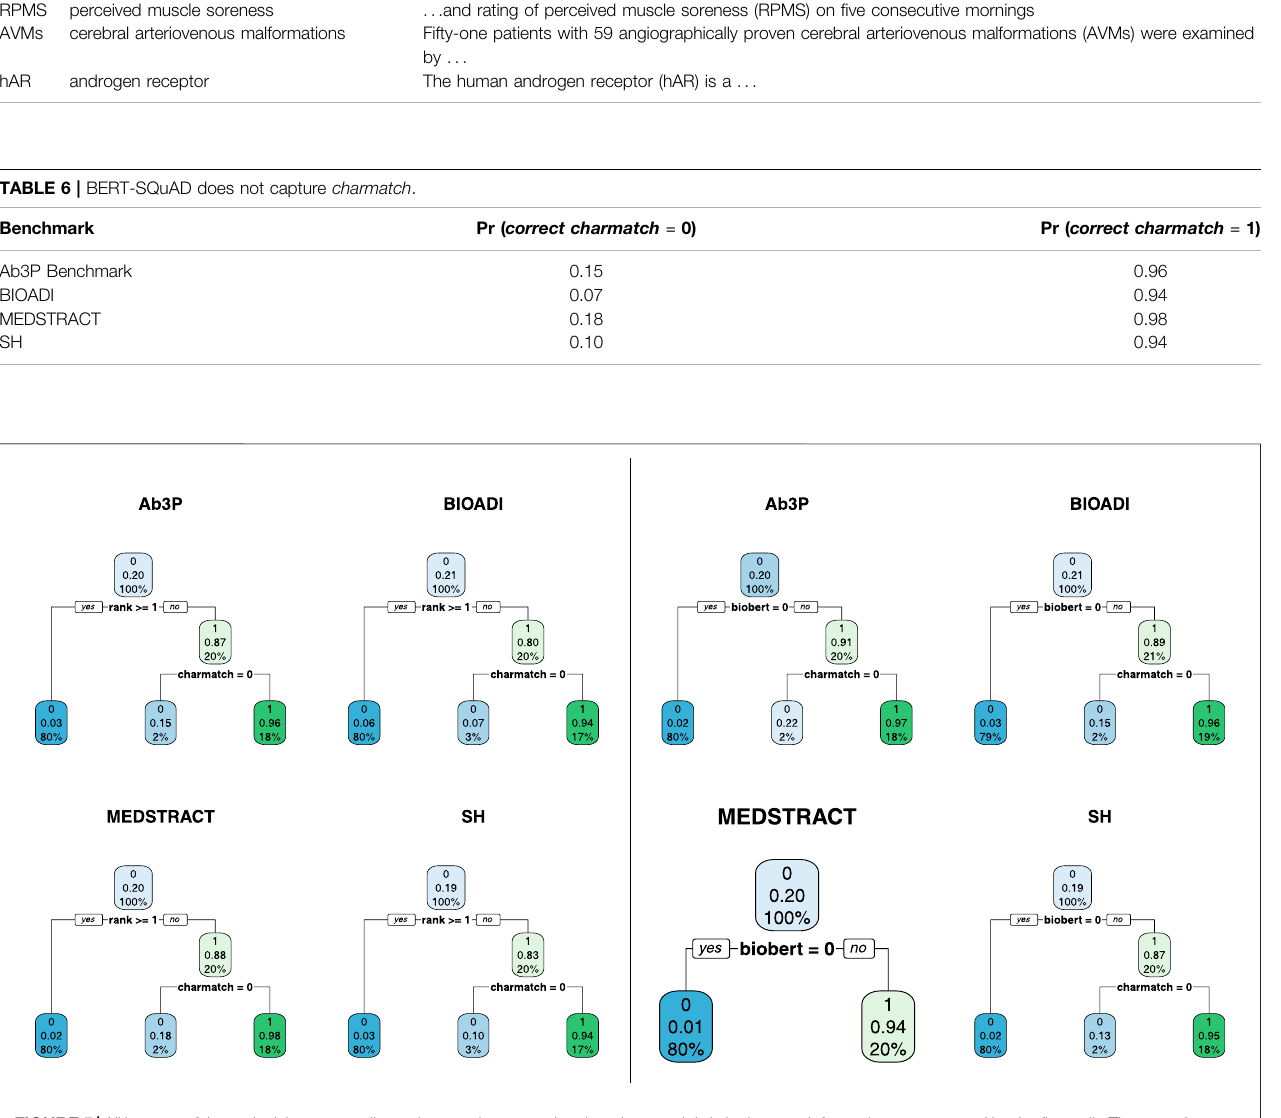
FIGURE5| Allbut oneofthese decision treesspliton charmatch , suggesting thatcharmatch isbringingnewinformationnot captured bythe fi rst split.There are8 trees (4 benchmarks and 2 equations). The four trees on the left use Eq. 1 and the four on the right use Eq. 2 .